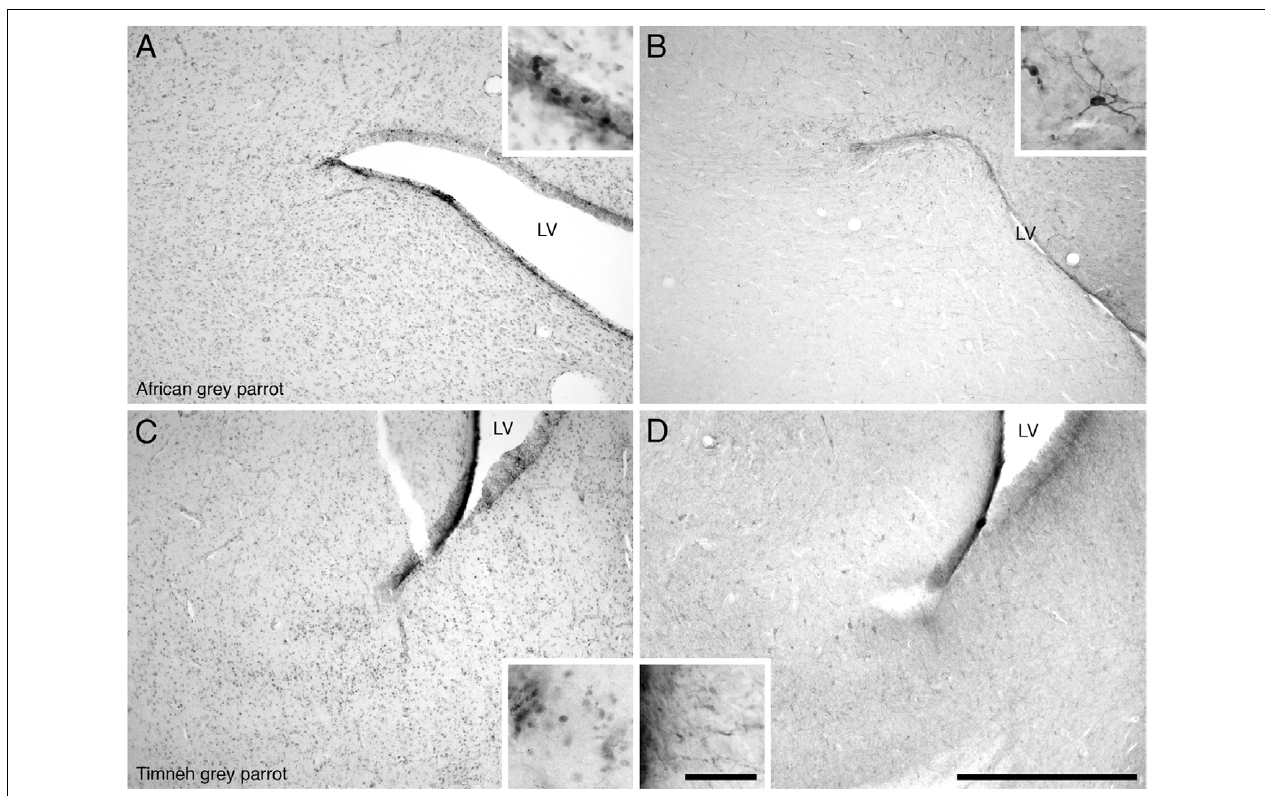
FIGURE 4 | Photomicrographs of PCNA – (A,C) and DCX (B,D) – immunostained coronal sections through the subventricular zones (SVZ) of the lateral ventricle in the brains of the two parrot species – (A,B) – African grey parrot ( Psittacus erithacus ), (C,D) – Timneh grey parrot ( Psittacus timneh ). PCNA immunoreactivity revealed aggregates of proliferating cells (hot spots) in the SVZ of the dorsal pole of the lateral ventricle in the African grey parrot ( Psittacus erithacus ) (A) , and ventral pole of the lateral ventricle in Timneh grey parrot ( Psittacus timneh ) (C) . Insets in (A,C) show a higher magnification images of PCNA immunoreactive cells. DCX immunoreactivity revealed aggregates of DCX-immunoreactive cells and fibers in the SVZ of the dorsal pole of the lateral ventricle in the African grey parrot ( Psittacus erithacus ) (B) , and in the ventral pole of the lateral ventricle in the Timneh grey parrot ( Psittacus timneh ) (D) . Insets in (B,D) show a higher magnification of DCX immunoreactive cells and fibers. All high power images on inserts were taken from consecutive sections to low power images. In all images dorsal is to the top and medial to the right. Scale bar in (D) = 500 µ m and applies to all. The scale bar in the inset in (D) = 50 µ m and applies to all insets. LV, lateral